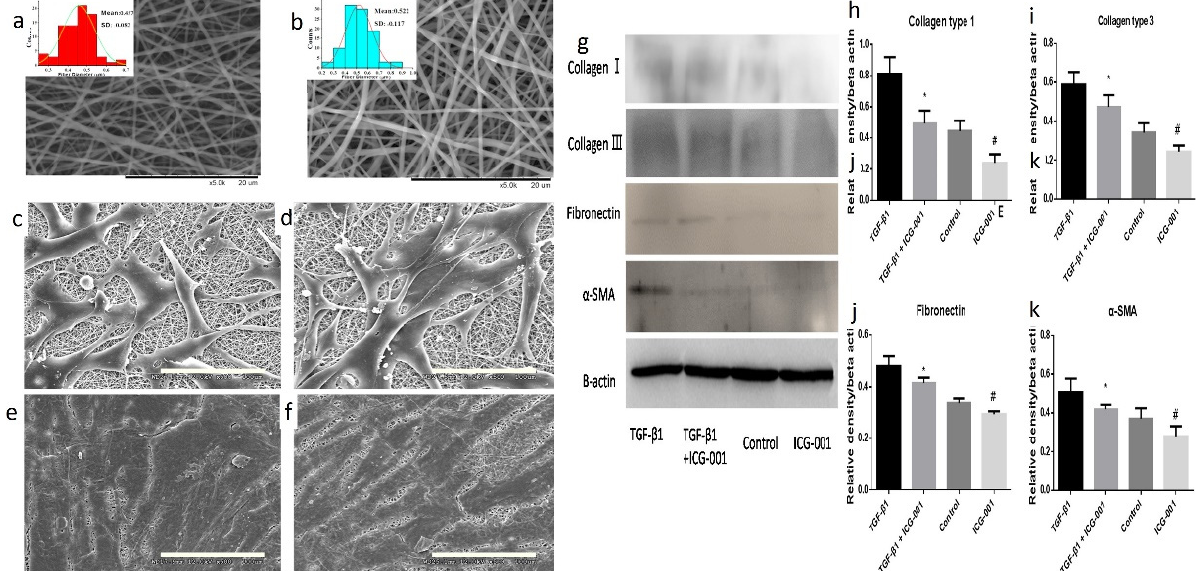
Figure 10. ( a , b ) show the microarchitecture of ICG-001-loaded and ICG-001-free scaffolds. ( c ) and ( e ) show the adhesion of epithelial cells on collagen/PLLA-CL scaffolds on days 3 and 7. ( d , f ) show the adhesion of epithelial cells on collagen/PLLA-CL/ICG-001 scaffolds on days 3 and 7. ( g – k ) show the Western blotting images of different proteins in fibroblast cells treated with TGF β -1 and medium released from ICG-001/scaffolds. * and # show p -value < 0.05. Adopted from reference [232]. ( c – f ) Scale bars, 100 μ m.